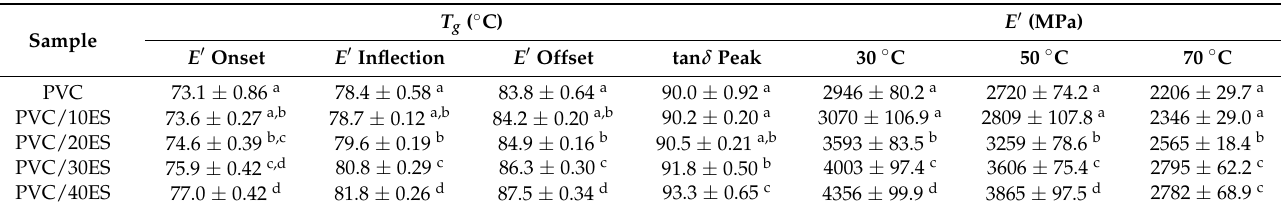
Figure 8. Thermograms of DMA analysis of PVC and PVC/40ES. Table 5. Characteristic values of DMA analysis.